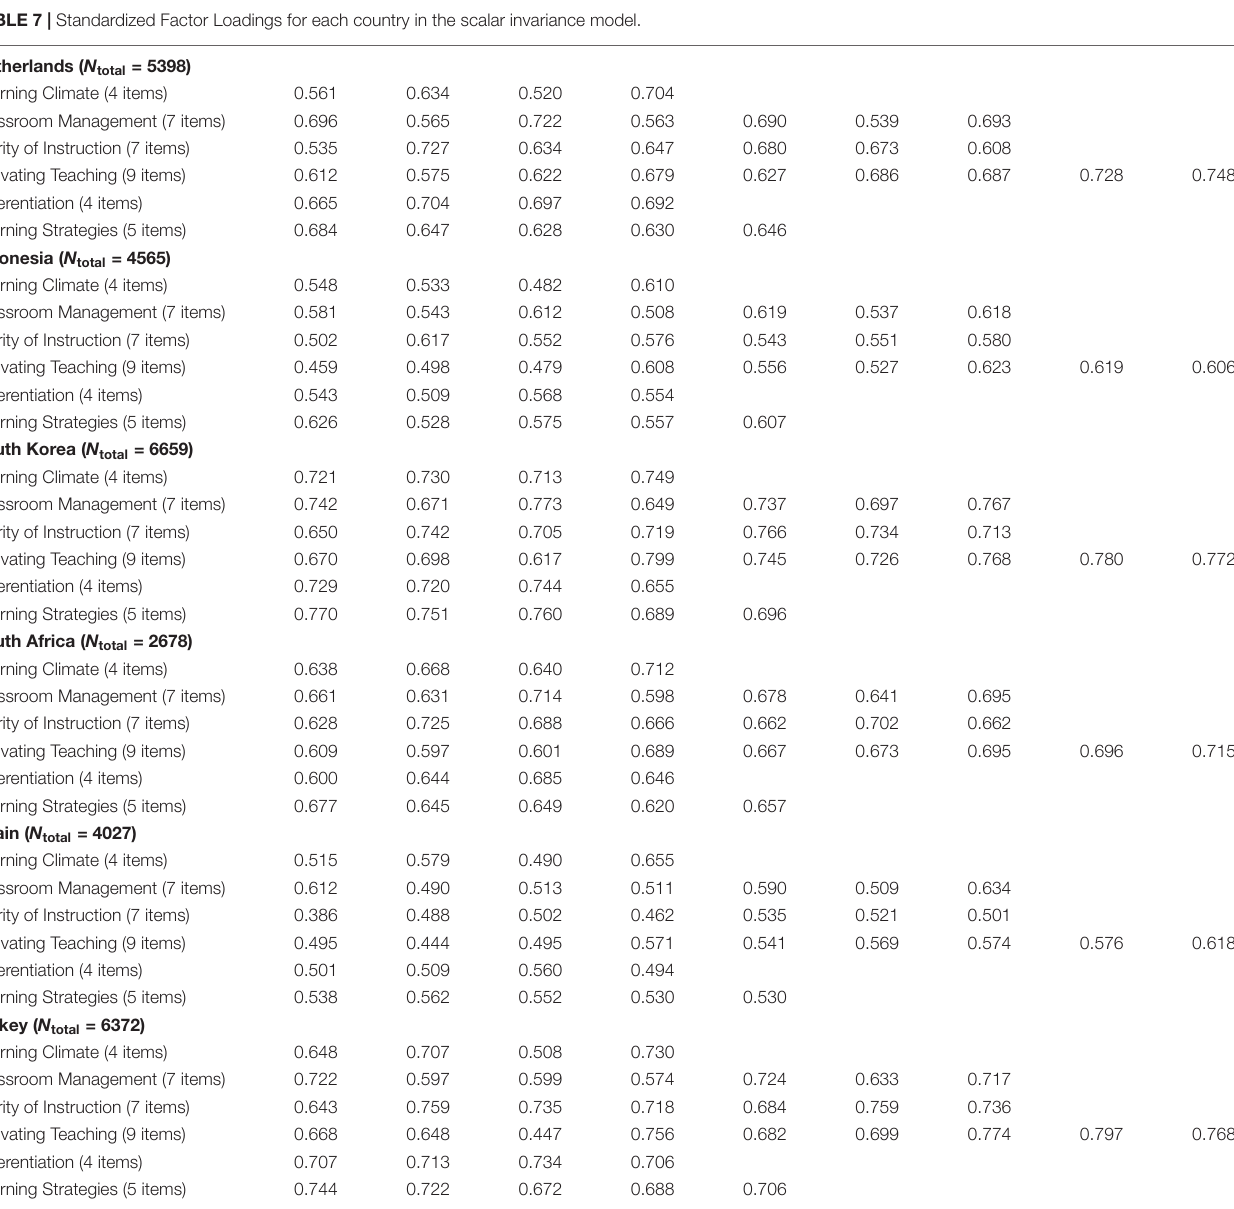
TABLE 7 | Standardized Factor Loadings for each country in the scalar invariance